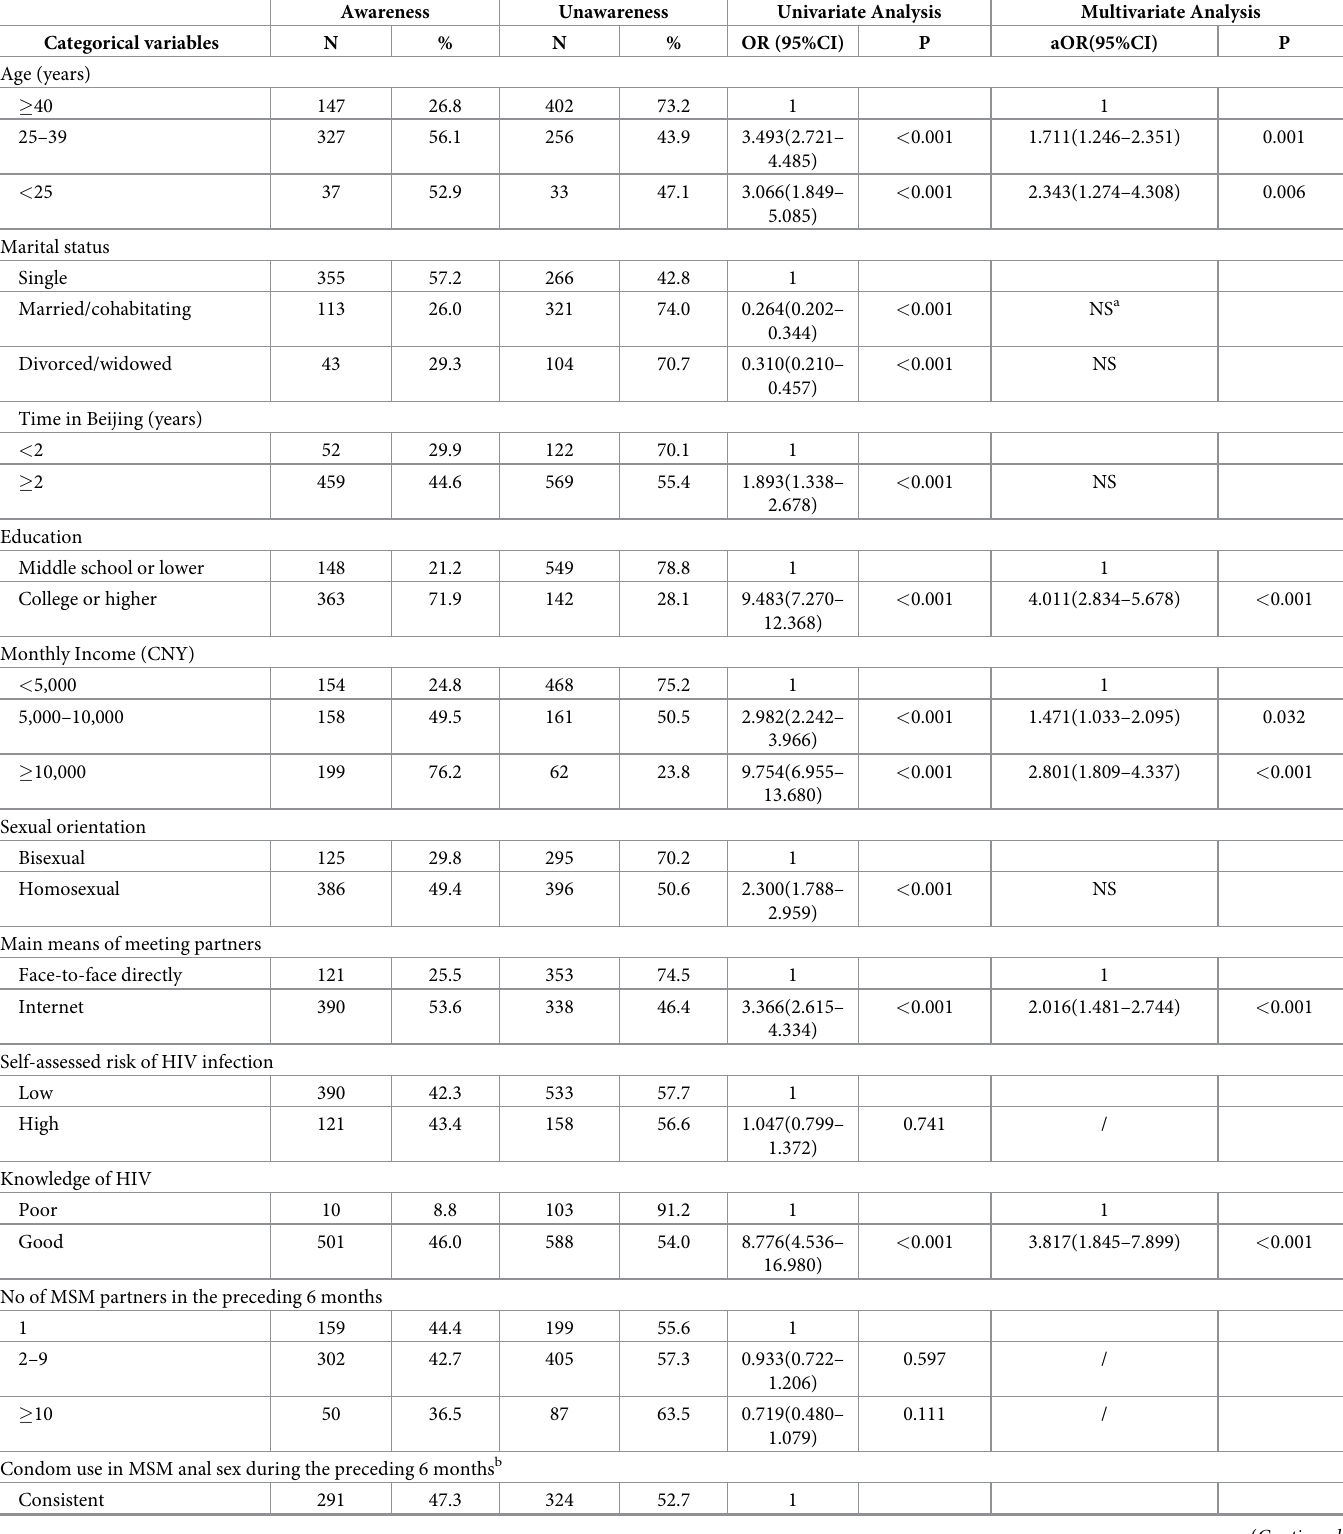
Table 4. Factors associated with the nPEP awareness among MSM recruited in 2018 and 2019 in Beijing,